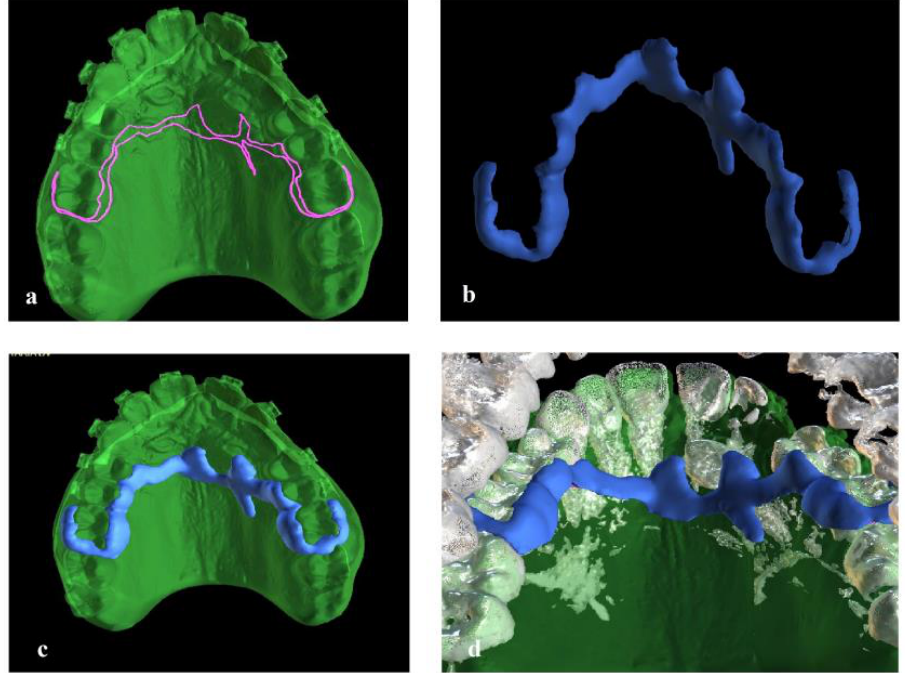
Figure 3. ( a , b ): The design (purple color) and the .STL file (blue color) of the device. ( c , d ): The device on the digital model (patient 1).